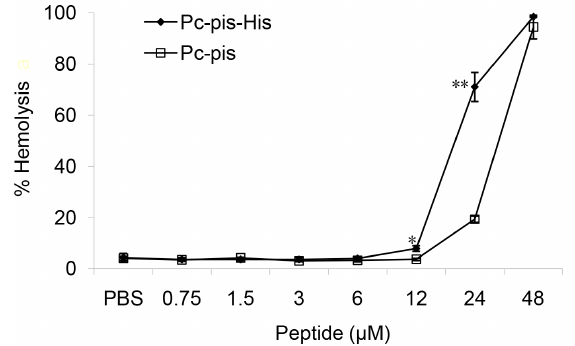
Figure 4. Dose-response of hemolytic activity of Pc-pis-His and Pc-pis against human erythrocytes. The data are expressed as the means 6 SD (N $ 3). An asterisk (*) and two asterisks (**) represent a significant difference ( P , 0.05) and an extremely significant difference ( P , 0.01) between the Pc-pis-His group and the Pc-pis group at each concentration, respectively.